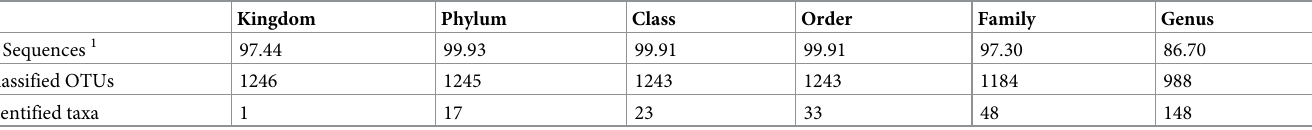
Total OTU number, % of sequences assigned to a known taxon at different ranks and unique taxa found at each rank. 1 Proportion of total reads classified to phylum and lower taxonomic levels are calculated relative to the total reads after filtering OTUs not assigned to Bacteria